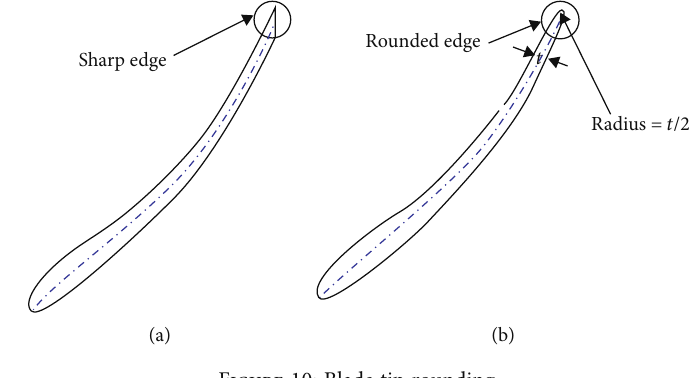
Figure 10: Blade tip rounding.